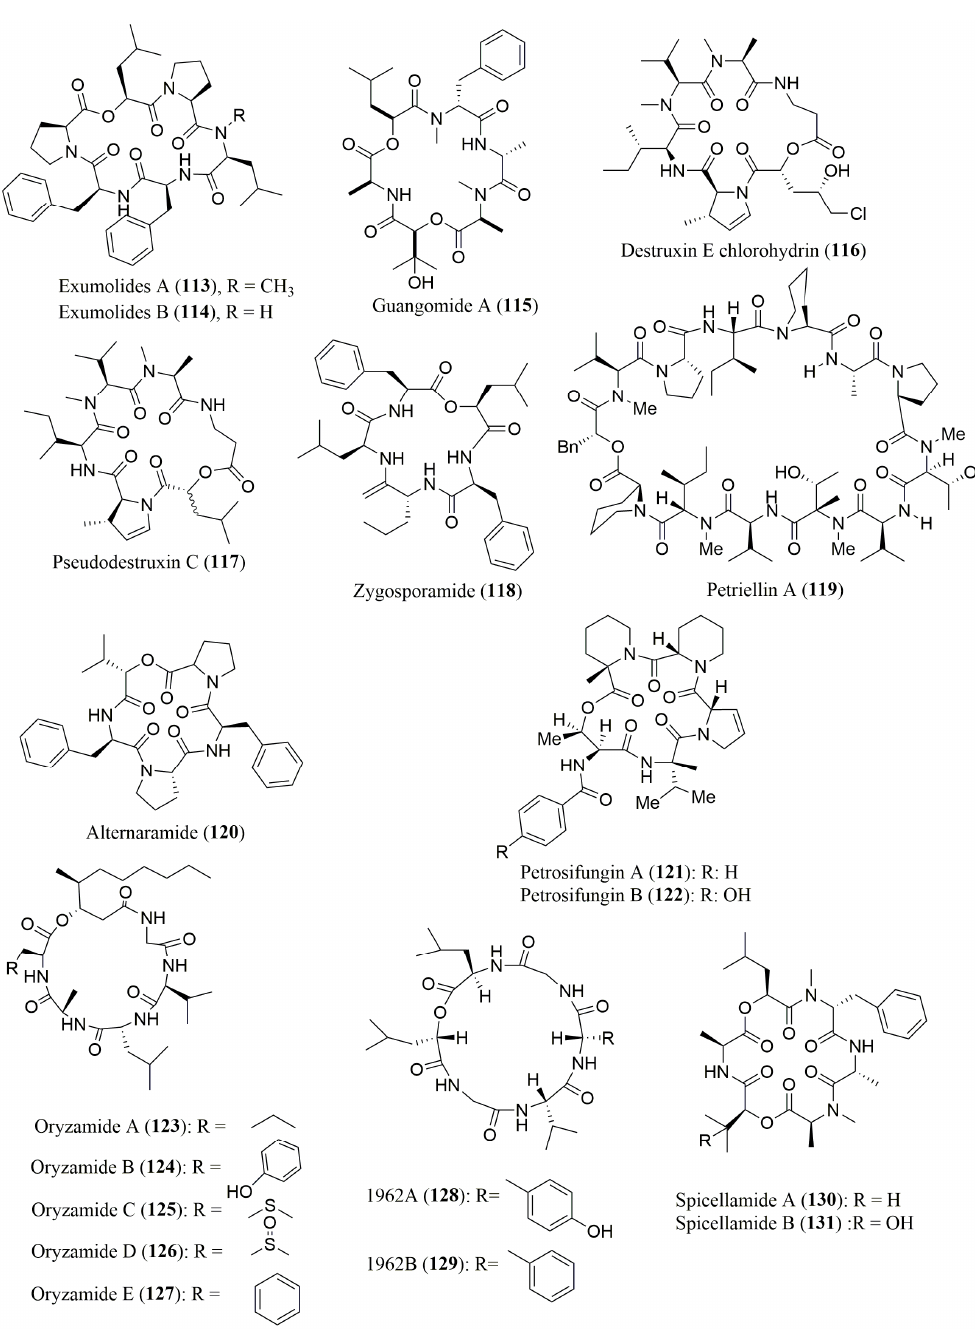
Figure 9. Structure of cyclic depsipeptides 113 – 131 , isolated from marine-derived fungi.